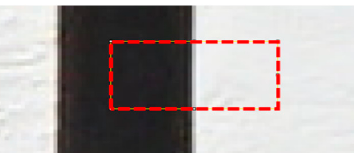
Figure 9. Crack specimen image near the boundary line of the crack to analyze the visibility resolution.